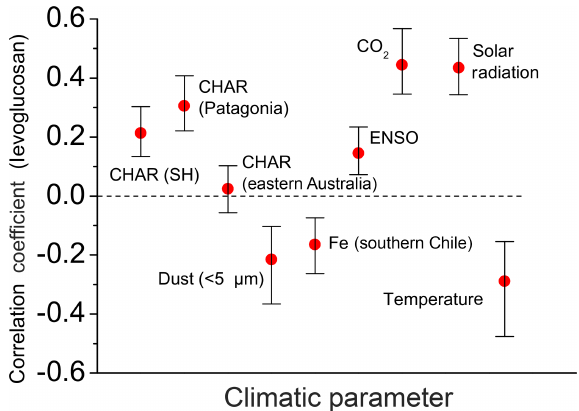
Figure 5. Slot correlation with 95% bootstrap confidence interval between levoglucosan recorded at Talos Dome (log transformed) and (i) charcoal synthesis (CHAR) from Patagonia, (ii) eastern Aus- tralia, (iii) the Southern Hemisphere, (iv) dust particles at Talos Dome (from Albani et al., 2012), (v) iron record from southern Chile (Lamy et al., 2001), (vi) carbon dioxide from Taylor Dome (Indermühle et al., 1999), (vii) ENSO 100-year frequency (Moy et al., 2002), (viii) October–February 45 ◦ S solar radiation (from Laskar et al., 2004), and (ix) temperature anomalies between 30 and 90 ◦ S (Marcott et al.,